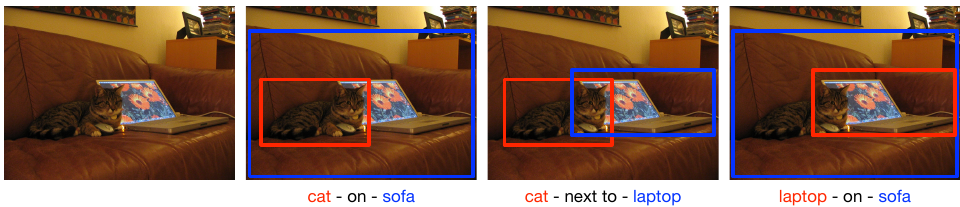
Figure 1. Visual relationship detection examples between different objects. A visual relationship is composed of three parts, i.e.,